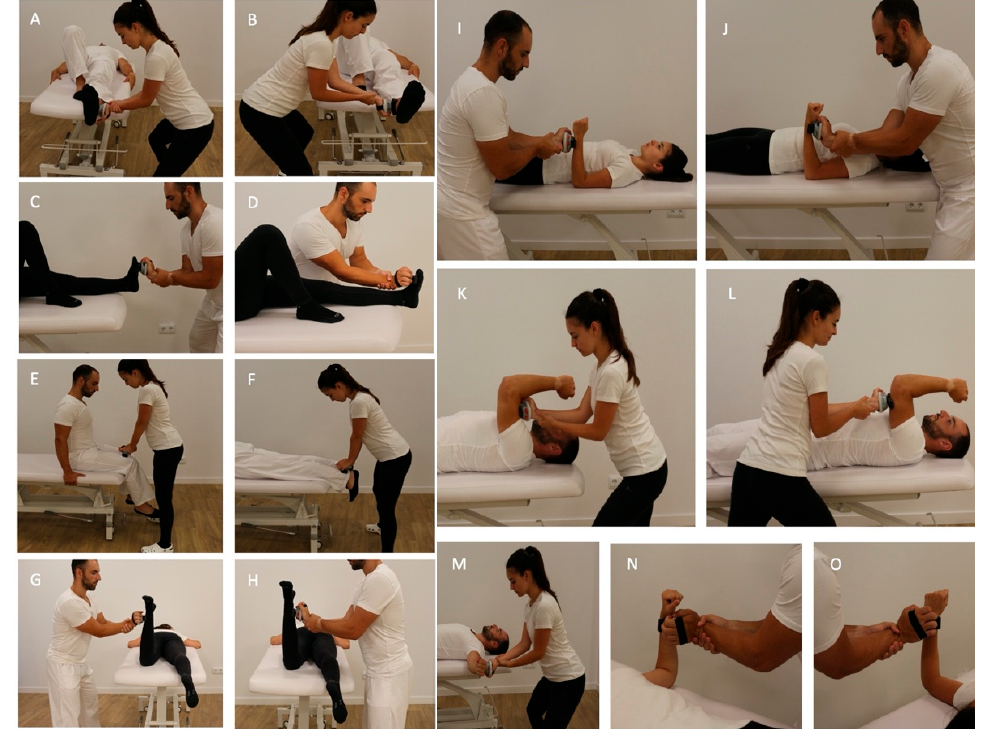
Figure A2. Isometric strength tests using push HHD for: hip abduction ( A ), hip adduction ( B ), ankle flexion ( C ), ankle extension ( D ), hip flexion ( E ), hip extension ( F ), hip rotation internal ( G ), hip rotation external ( H ), elbow extension ( I ), elbow flexion ( J ), shoulder flexion ( K ), shoulder extension ( L ), shoulder abduction ( M ), shoulder internal rotation ( N ), and shoulder internal external ( O ).